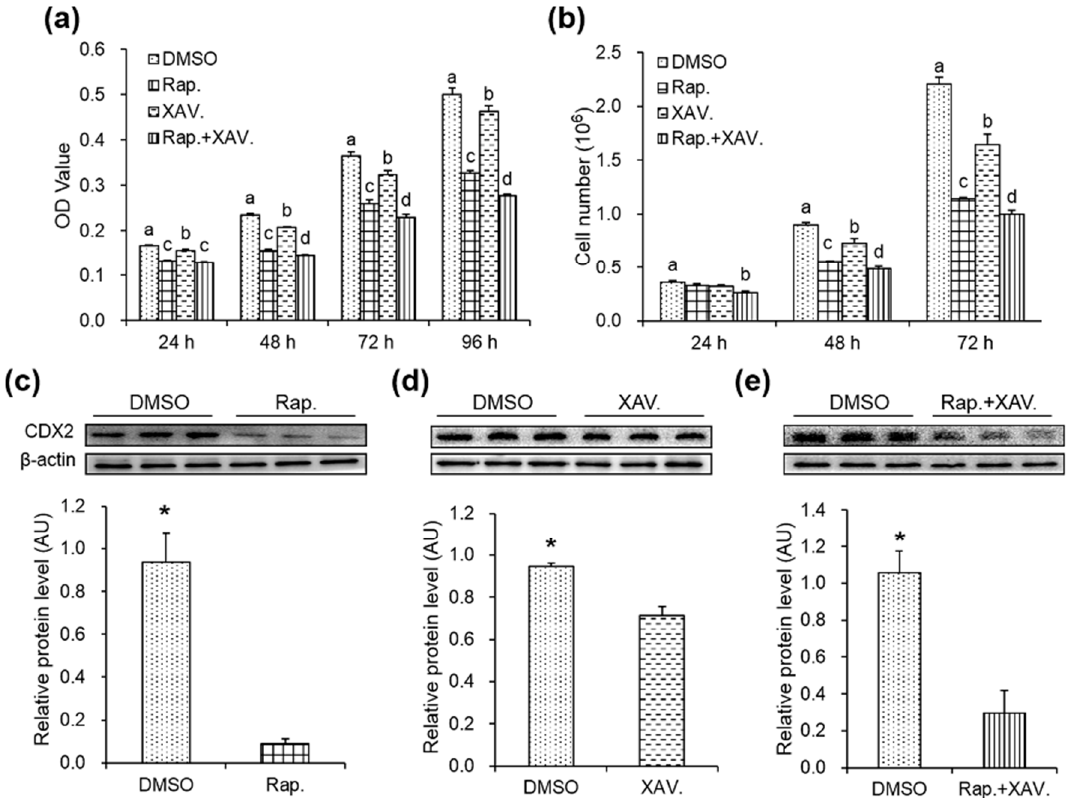
Figure 5. Specific antagonists decreased cell proliferation and the protein level of CDX2 in CDX2 overexpressed IPEC-J2 cells. ( a,b ) OD values and cell numbers were assessed by MTT assay ( n = 20) and cell counting ( n = 6), respectively; ( c – e ) protein levels of CDX2 were measured by Western blot after treated with rapamycin and XAV939 alone or in combination with quantification ( n = 3). AU: arbitrary unit. DMSO: DMSO treatment group; Rap.: rapamycin treatment group; XAV.: XAV939 treatment group; Rap. + XAV.: combination of rapamycin and XAV939 treatment group. Representative results of three independent experiments are shown. Data are expressed as the mean ± SEM; bars without the same letter indicate a significant difference; * p < 0.05.